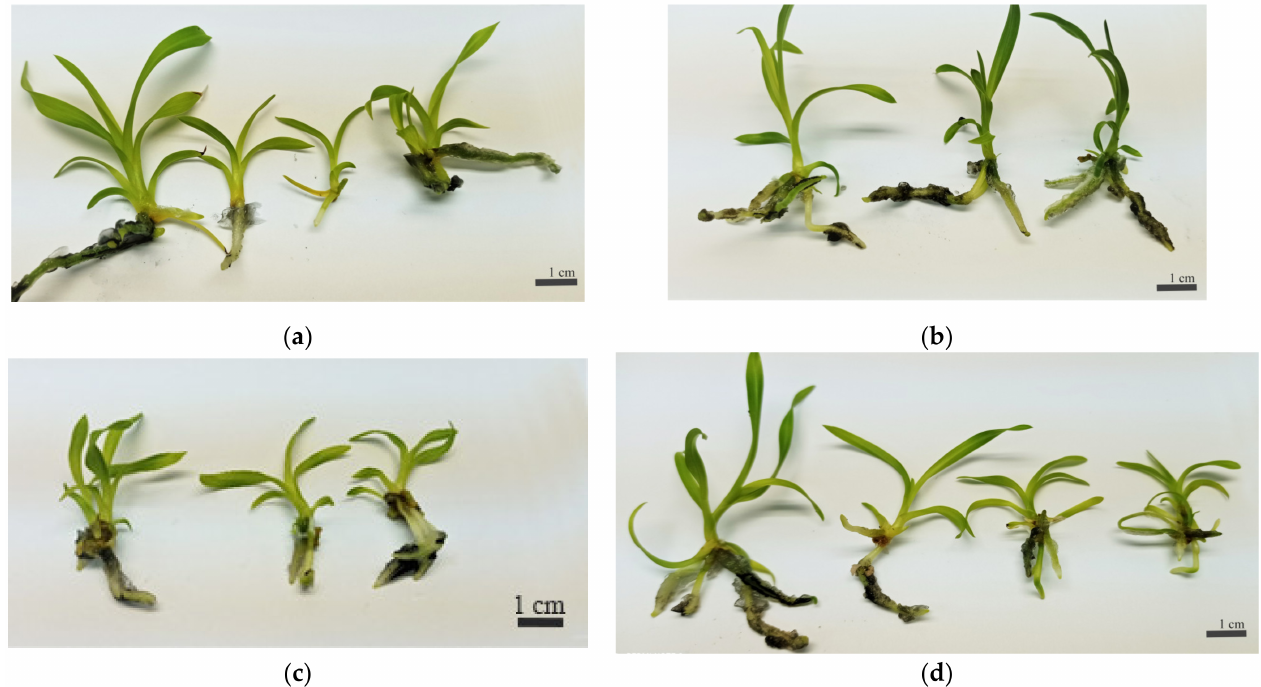
Figure 6. Effect of organic supplements on root parameters of C. erythrostylum seedlings: ( a ) 0.5 mg/L IBA (control); ( b ) 0.5 mg/L IBA + banana puree; ( c ) 0.5 mg/L IBA + coconut water; ( d ) 0.5 mg/L IBA + sweet potato.